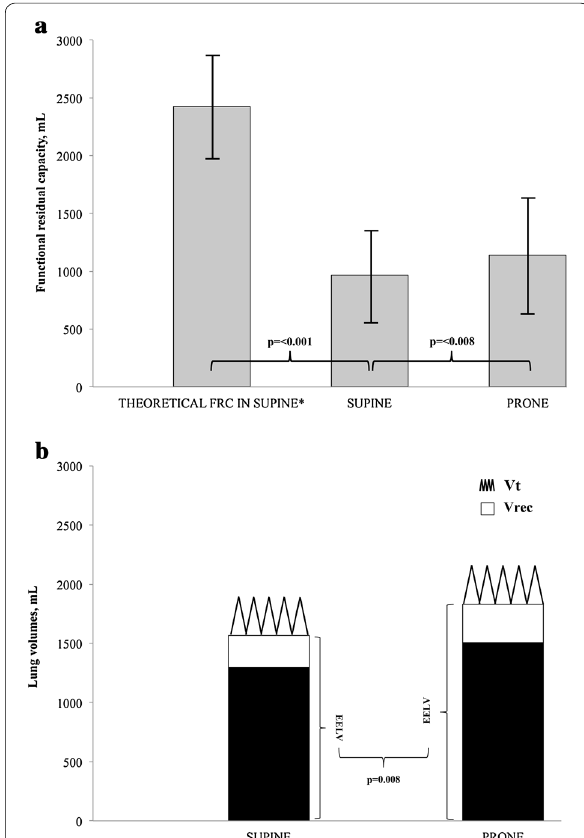
Fig. 2 Variation of lung volumes with the change of position. a Comparison of different values of functional residual capacity. b Comparison of EELV and Vrec in supine position and prone position. EELV, end‑expiratory lung volume; Vrec, PEEP‑induced lung volume recruitment; Vt, tidal volume. Data are presented in mean (ml) and SD. *According to the equation described by Ibañez and Raurich